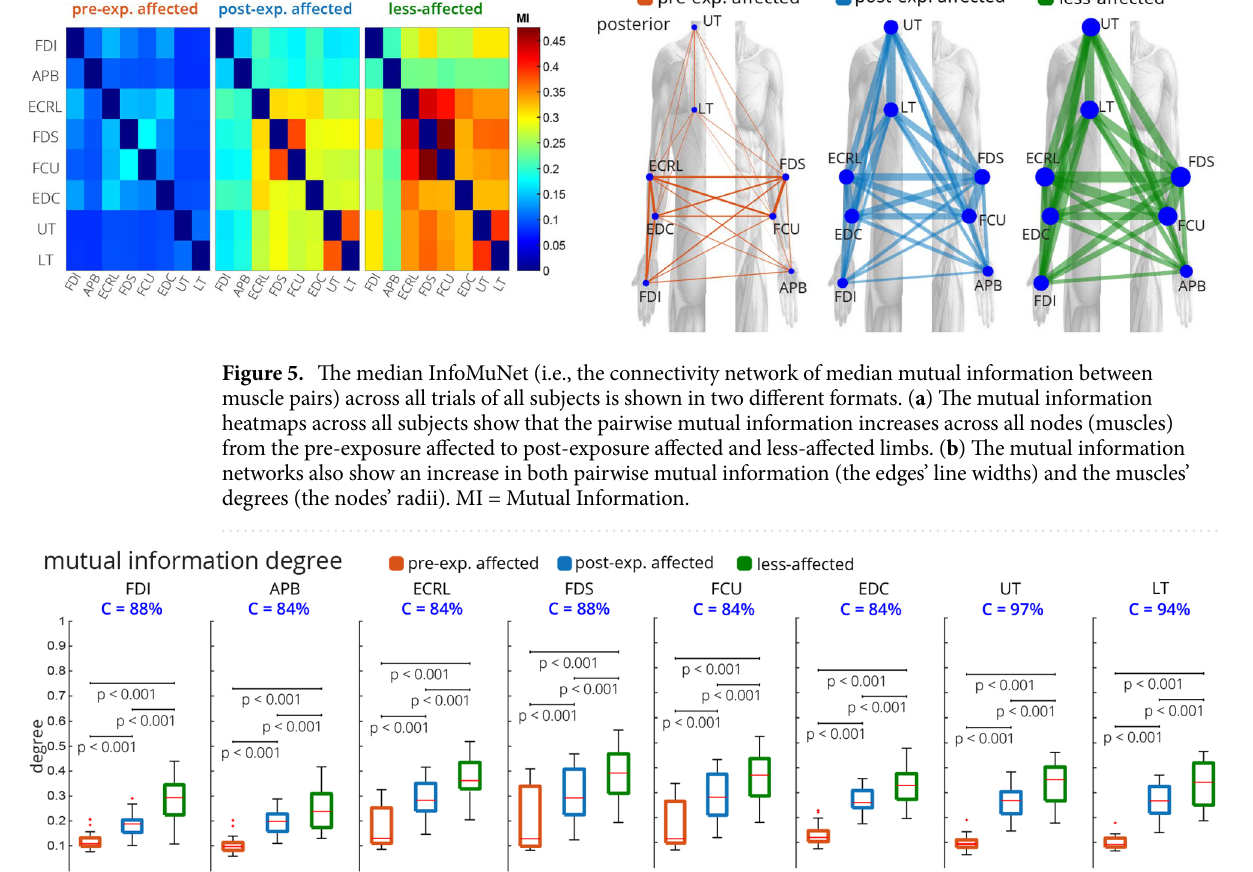
Figure 6. Mutual information degree for individual muscles across all n = 32 subjects. For each subject, the mutual information degree was quantified for the median muscle network across all trials. All muscles showed a significant monotonic increase in degree from pre-exposure affected to post-exposure affected and less-affected limbs. The conformity for all muscles was > 80%. The UT and LT muscles had the highest conformity at ≥